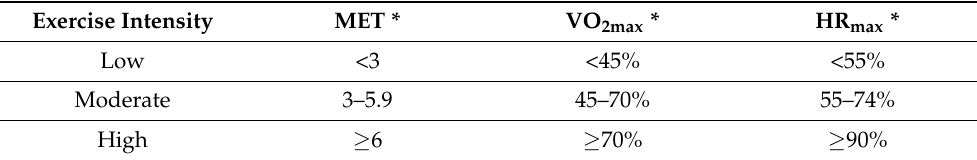
Table 1. Commonly accepted definitions of the different intensity levels of aerobic exercise.